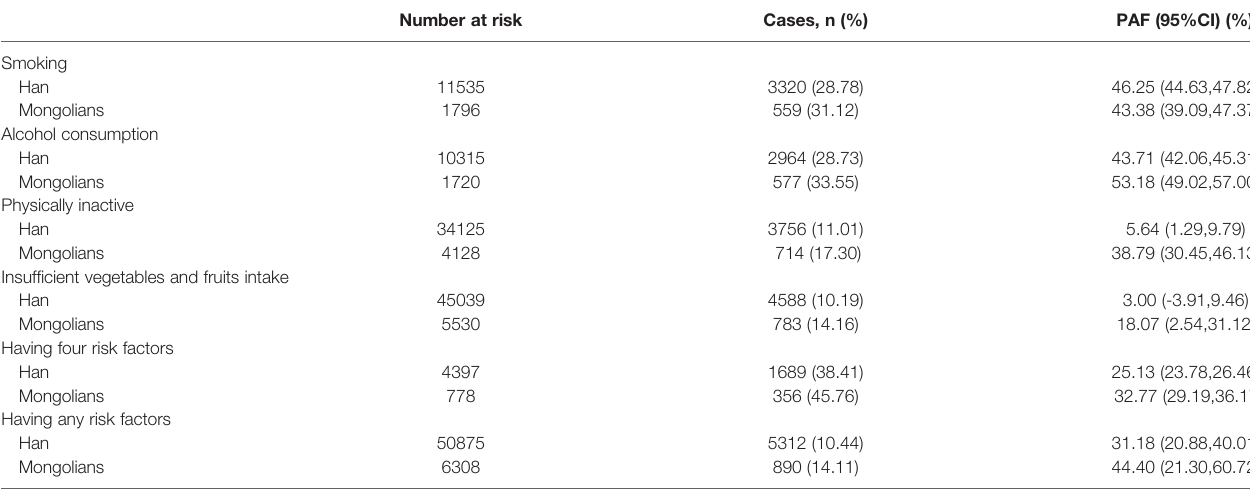
OR, odds ratio; CI, con fi dence interval. *Smokers were de fi ned as those who had smoked ≥ 1 cigarette (or equivalent) per day for at least 6 months. Alcohol consumption was de fi ned as drinking alcohol at least once a week on average for more than 6 consecutive months. Regular physical activity was de fi ned as exercise at least ≥ 30 minutes on 3 days of the week. Insuf fi cient vegetables and fruits intake was de fi ned as consuming less than 360g vegetables and 180g fruits per day on average. † Population attributable fraction was adjusted for age, sex, education, occupation, body mass index and family history, and there are 325 (0.53%) missing values in body mass index.